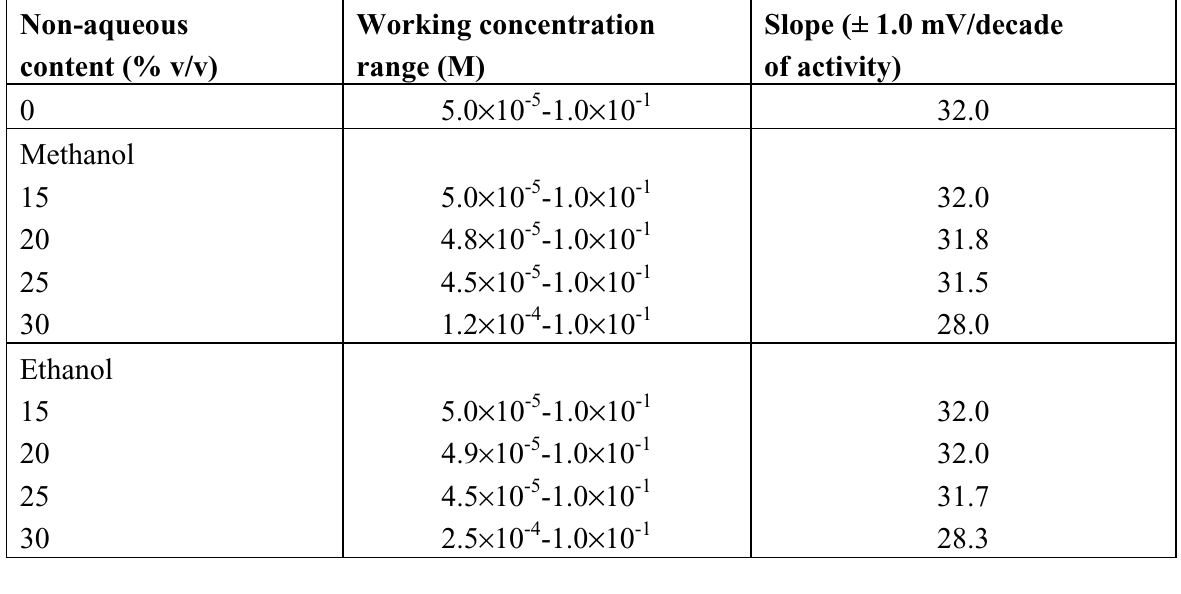
Table 3. Response of MoO 42- sensor (no. 2) in partially aqueous medium.